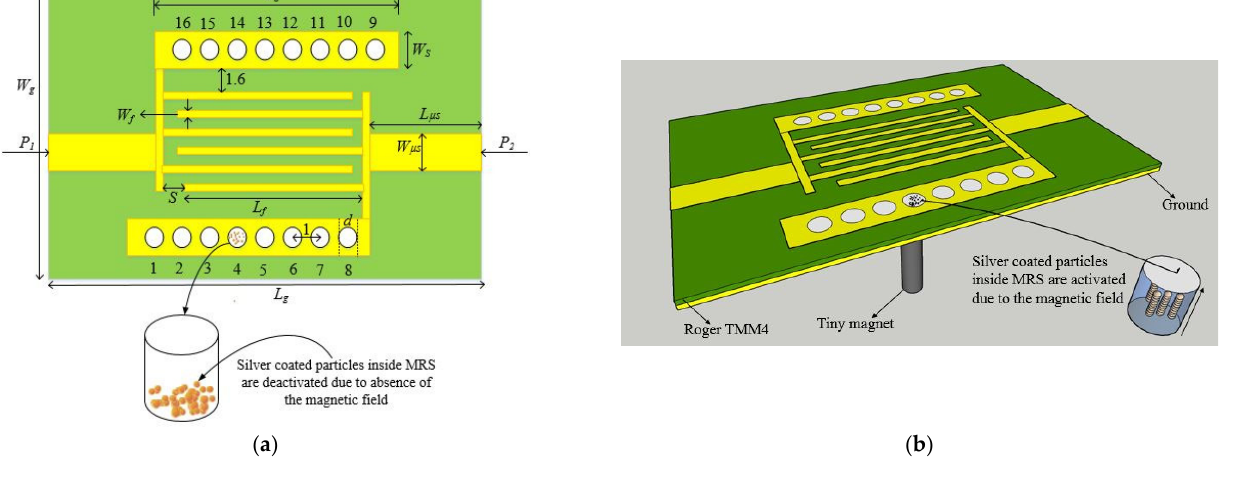
Figure 1. ( a ) P-CRLH unit cell top view ( All dimensions are in mm : L S = 8, W S = 1, W f = 0.3, L f = 6, L µ s = 7.6, W µ s = 1.8, d = 0.6, W g = 9, L g = 22, S = 0.2 ) ; ( b ) P-CRLH unit cell 3D